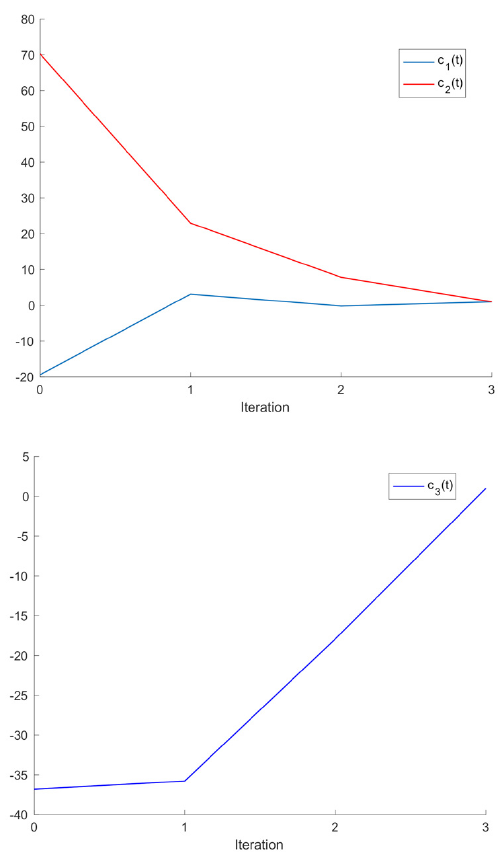
Figure 4. Demands vector in Example